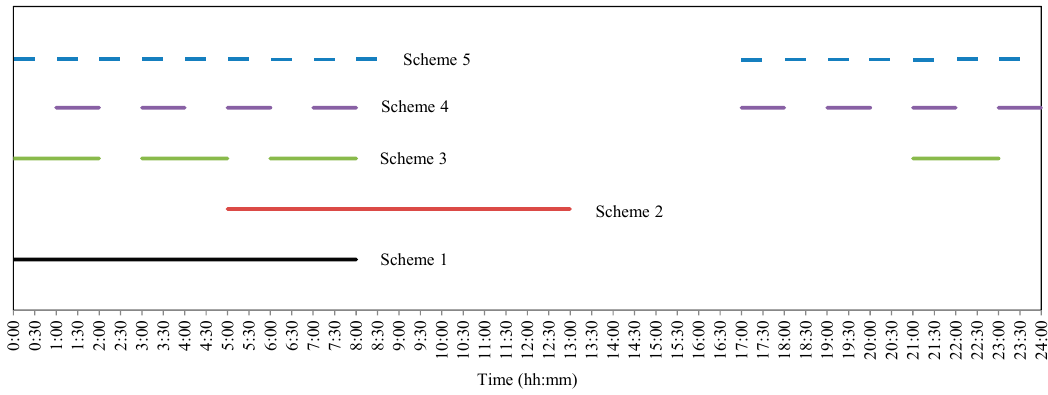
Figure 13. Di ff erent cooling time distribution Figure 13. Different cooling time distribution schemes.